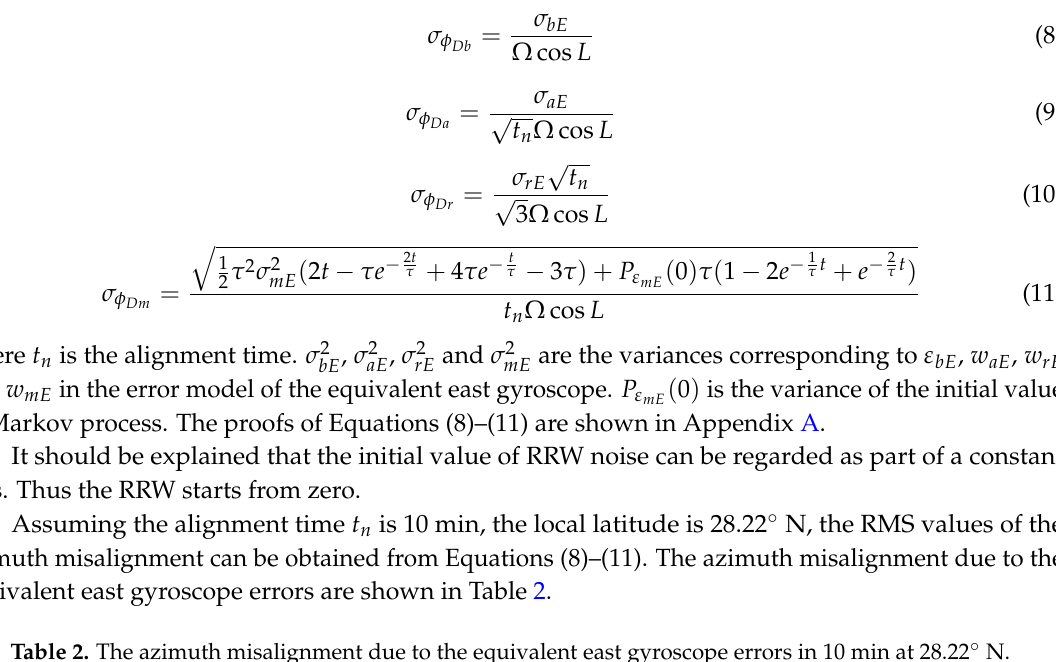
Table 2. The azimuth misalignment due to the equivalent east gyroscope errors in 10 min at 28.22 ◦ N. Gyroscope